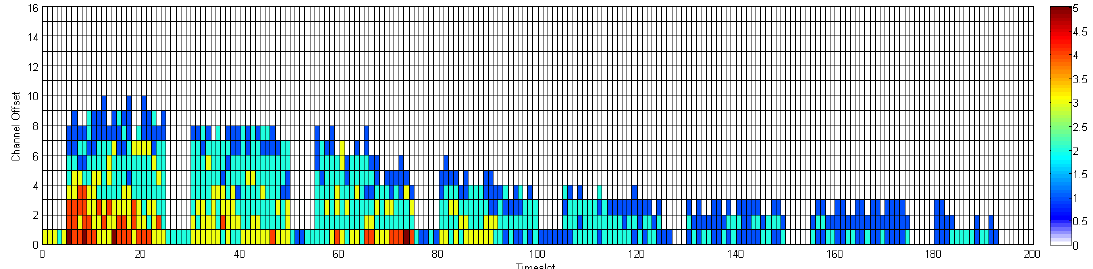
Figure A5. Communication schedule of D-MSR network with 21 nodes per one-hop neighborhood.